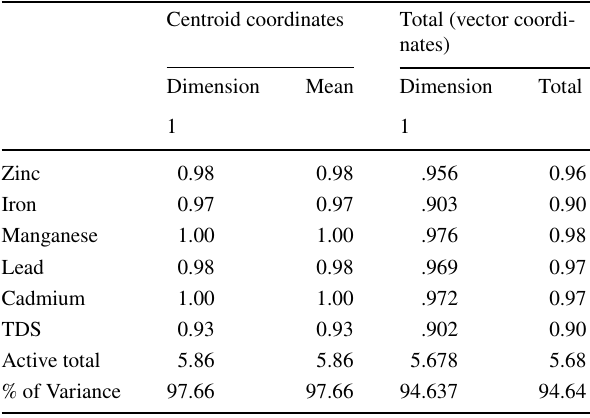
Table 8 Centroid coordinates and total variance